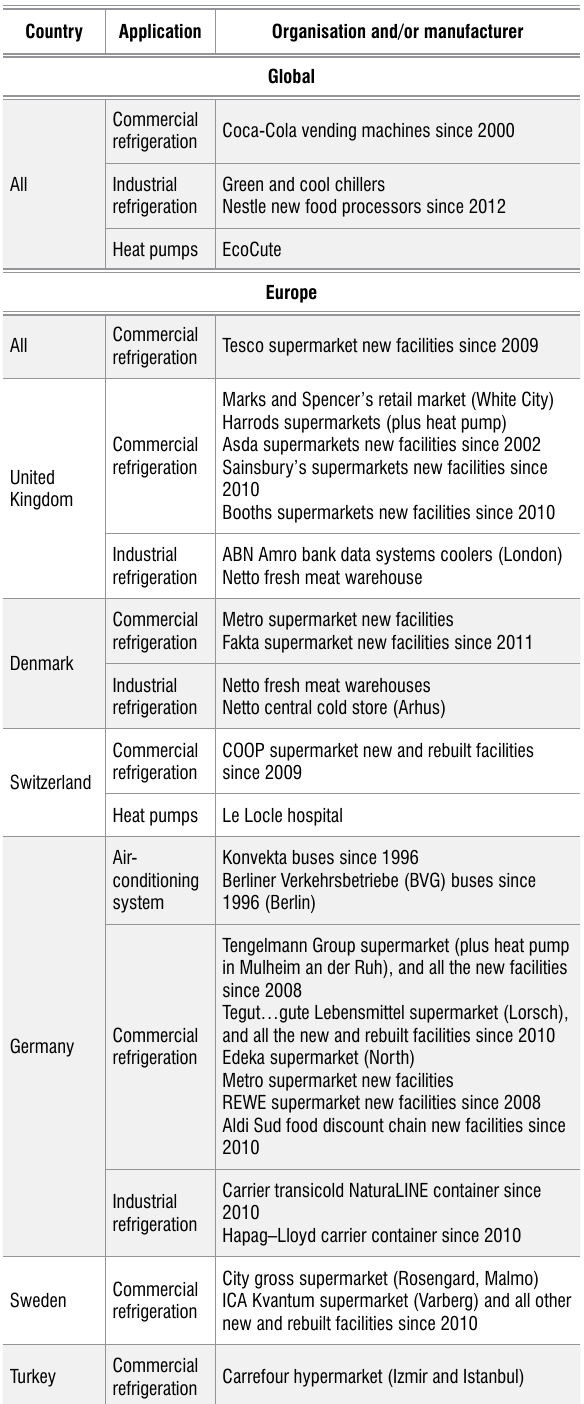
Table 4: Some existing practical examples of NH